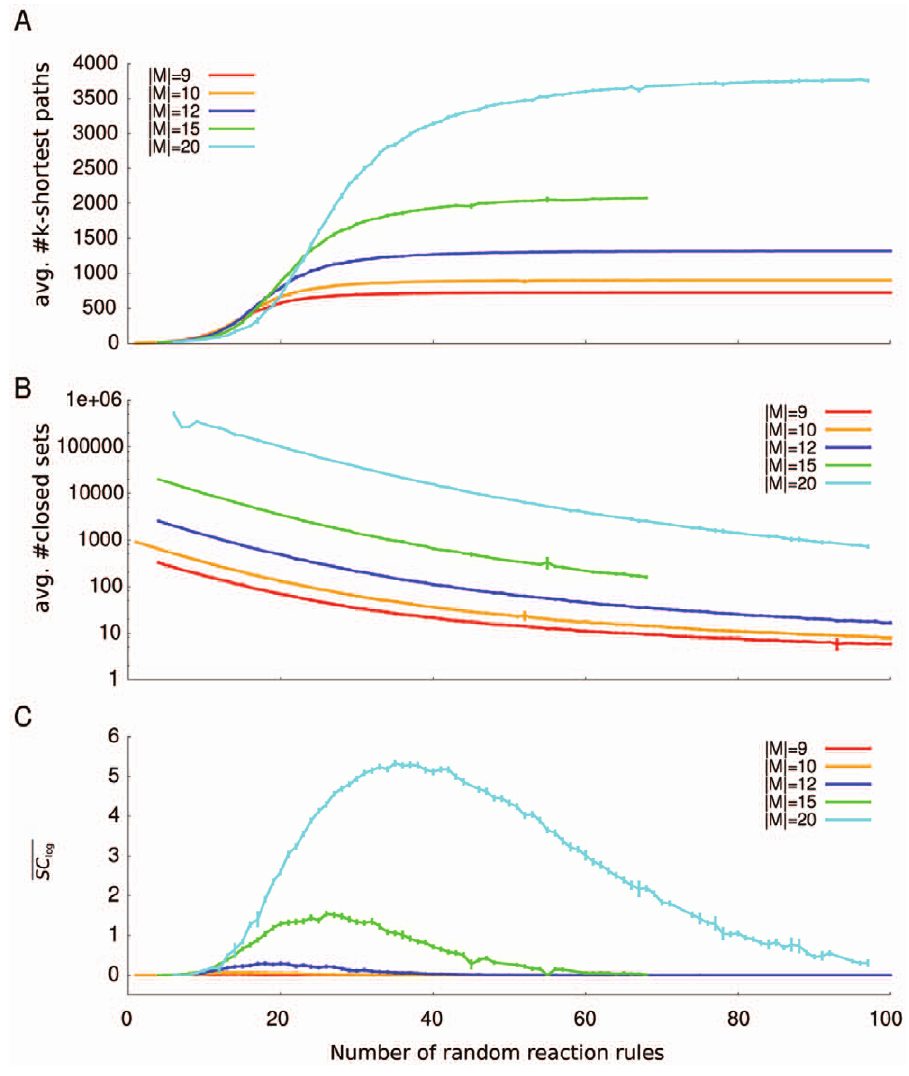
Figure 5. Structural properties of random reaction networks of different size and density. Panels A and B show two important network parameters for five different network sizes over the numbers of reaction rules. The data represents the average values of random replicates. Error bars indicate the standard error of the mean. Panel A shows the average number of paths in the network. Since we applied the path algorithm which only uses the k-shortest paths between each pair of molecular species the curve shows a sigmoidal behavior, which is saturated at the value D M D : ( D M D { 1) , with k ~ 10 . Panel B shows the average number of closed sets. With growing density the number of closed sets decreases. Panel C shows the distributions of the average number of code pairs ( v SC log w ). The semantic capacity follows a unimodal distribution indicating the existence of an optimal interval for the random generation of the BMC motif. If the number of paths is too low no mappings can be implemented because of the missing links between potential signs and meanings. Similarly, if the number of closed sets is too low no mappings can be implemented